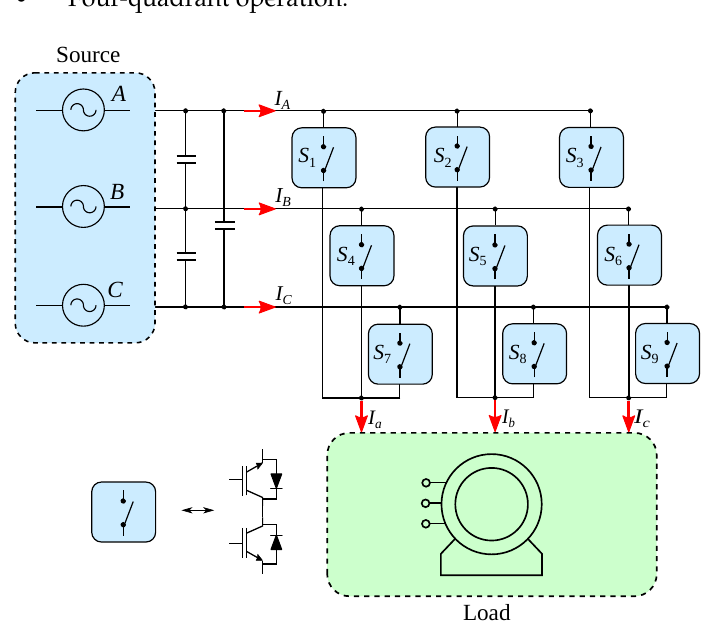
Figure 2. Basic CMC